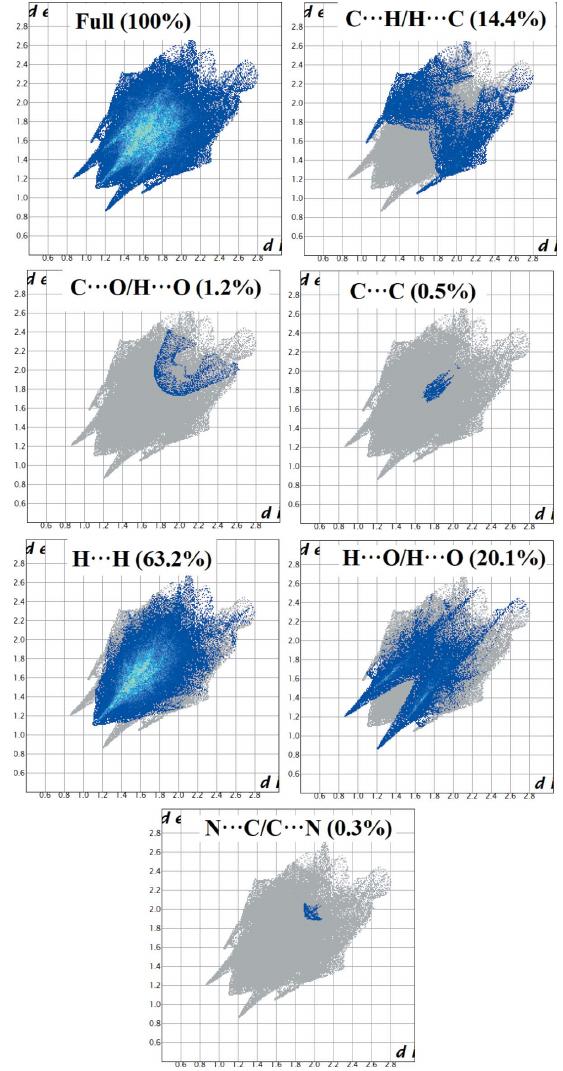
Figure 5 The two-dimensional fingerprint plot showing all interactions and those delineated into C (cid:2)(cid:2)(cid:2) H/H (cid:2)(cid:2)(cid:2) C, C (cid:2)(cid:2)(cid:2) O/O (cid:2)(cid:2)(cid:2) H, C (cid:2)(cid:2)(cid:2) C, H (cid:2)(cid:2)(cid:2) H, O (cid:2)(cid:2)(cid:2) H/ H (cid:2)(cid:2)(cid:2) O and N (cid:2)(cid:2)(cid:2) C/C (cid:2)(cid:2)(cid:2) N contacts.